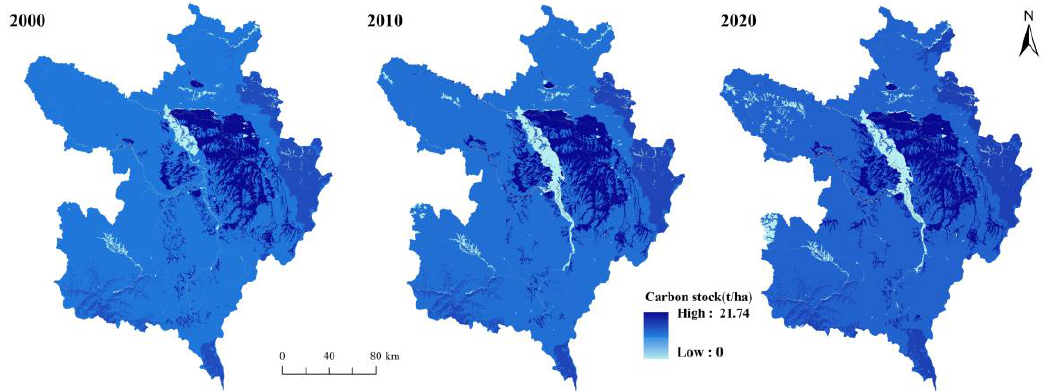
Figure 5. Spatial distribution of carbon stocks in the Zoigê alpine grassland area during 2000 – 2020.